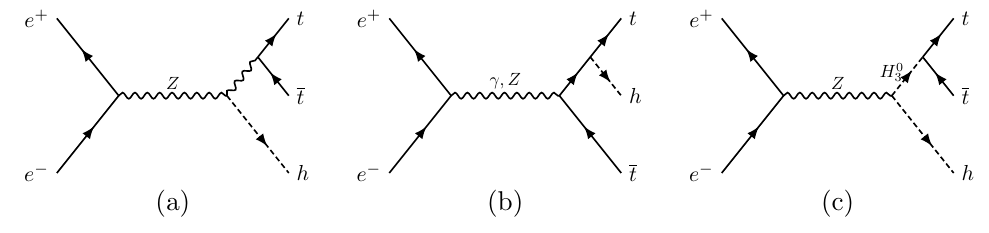
Figure 10 . Feynman diagrams for ht (cid:22) t production at e + e